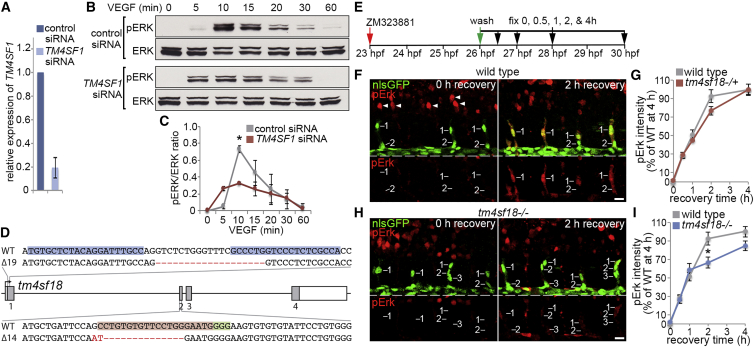
TM4SF1/Tm4sf18 Expression Feeds Back to Amplify VEGF/Vegf Signaling(A) Relative expression levels of TM4SF1 by qPCR in HUVECs transfected with control or TM4SF1-targeted siRNA (n = 4 separate experiments).(B and C) Western blot analysis of pERK/ERK levels in HUVECs after VEGF-A stimulation following transfection with control or TM4SF1-targetting siRNA (B) and quantification of pERK/ERK ratios (C) (n = 3 separate experiments).(D) Lesions introduced into the tm4sf18 loci by TALEN and CRISPR gene editing. A 19-bp deletion of tm4sf18 exon-1 and a 16-bp deletion and 2-bp insertion of exon-2 were generated using TALENs and CRISPR/Cas9, respectively. Genomic target sites for the TALENs, gRNA target site, and PAM sequence are indicated by blue, red, and green highlights, respectively.(E) Strategy for assessing Vegfr signaling dynamics in vivo.(F–I) Lateral views of pErk immunostaining in ECs of WT (F) or tm4sf18−/− (H) Tg(kdrl:nlsEGFP)zf109 embryos at 0 and 2 h after inhibitor washout and quantification of pErk fluorescence intensity in WT, tm4sf18+/− (G) or tm4sf18−/− (I) embryos. Arrowheads in (F) indicate pErk in neuronal cells (n = at least 39 ECs from 8 WT, 129 ECs from 20 tm4sf18+/−, and 74 ECs from 13 tm4sf18−/− embryos at each time point).Data are mean ± SEM. ∗p < 0.05, two-tailed t test. Scale bars, 25 μm.